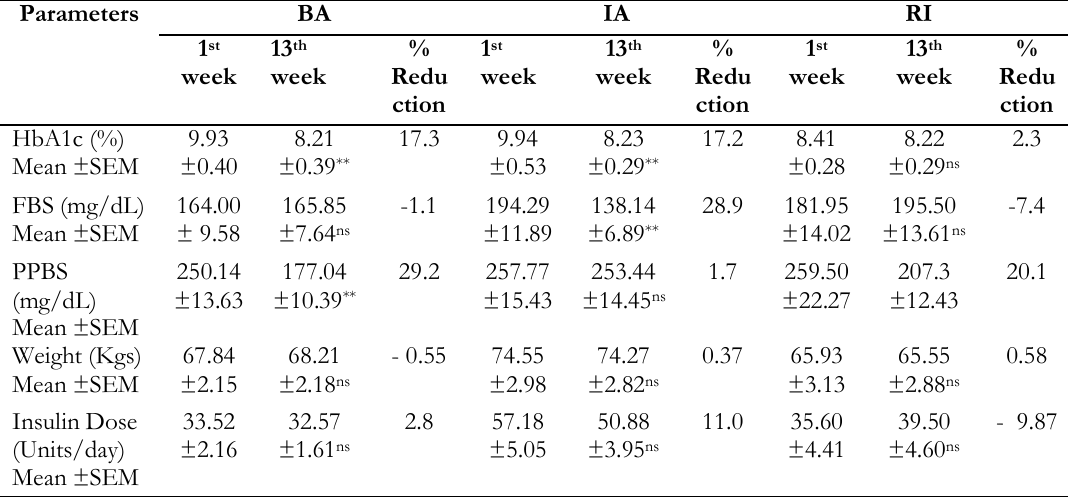
Table II. Effect of insulin therapy on safety and efficacy